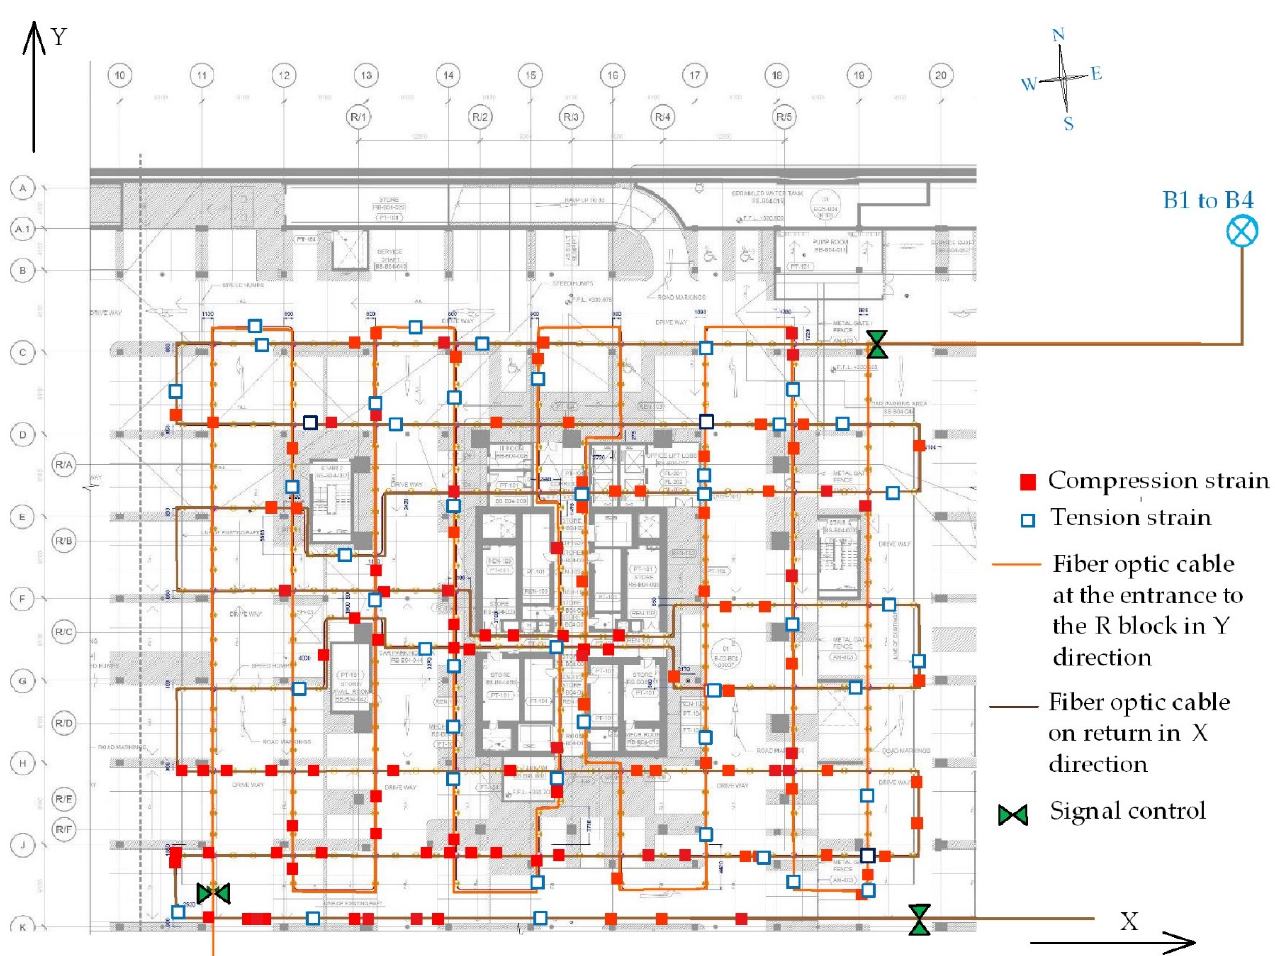
Figure 11. Fiber optic strain along the cable layout in block R, level B4.